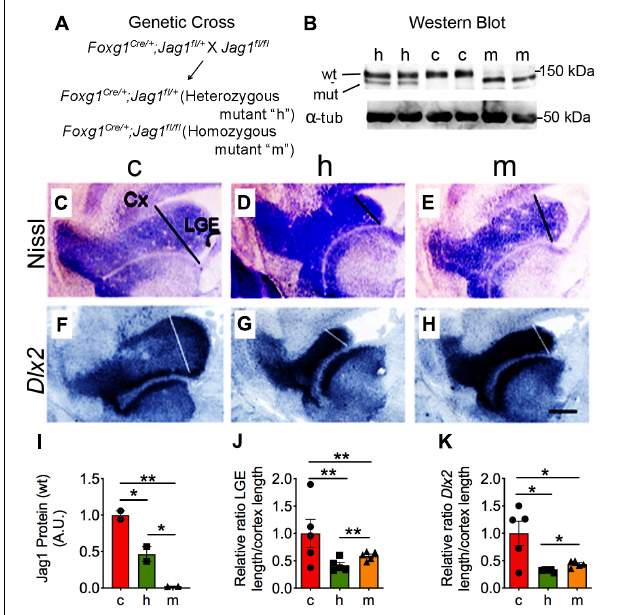
FIGURE 3 | Haploinsufficient Jag1 signaling shows reduced size of the LGE. (A) Schematic for the generation of Jag1 heterozygous (h) and homozygous (m) mutants. (B,I) Tissue from dLGE at E17.5 used in western blot shows substantial reduction in full-length (wt) Jag1 protein (150 kDa) expression in heterozygous and homozygous brains ( n = 2). Top band represents control (wt) and lower band mutant (mut) Jag1 protein. (C–E,J) The length of the Nissl staining in the LGE was significantly reduced in heterozygous and homozygous mice (c, n = 5; h, n = 5; m, n = 5). (F–H,K) The length of the expression of Dlx2 in situ probe was significantly reduced in both mutants (c, n = 5; h, n = 5; m, n = 5). Length for Nissl and Dlx2 LGE regions was determined by drawing a line from the point where the cortex meets the LGE to the point where the LGE connects with the ventral ventricle. All graphs show average ± SEM. Key to statistics: * p < 0.05; ** p < 0.01, respectively, in comparison to control or heterozygous. Five independent embryos ( n = 5) were counted and one section was selected to quantify for each genotype in Nissl and Dlx2 experiments. Scale bar = 300 µ m. Cx, cortex; LGE, lateral ganglionic eminence; wt, wild-type; A.U., arbitrary units; NS, not